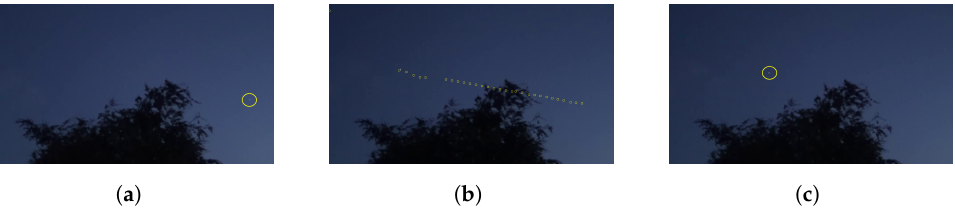
Figure 6. Satellite detection demonstration via video processing: ( a ) tracking the ISS at its rise; ( b ) tracking the ISS via video processing using the Kalman filter algorithm (note that the video was shot in low resolution, causing tracking breaks in several places); and ( c ) the final phase of the tracking (credit to RichardB1983 for the raw